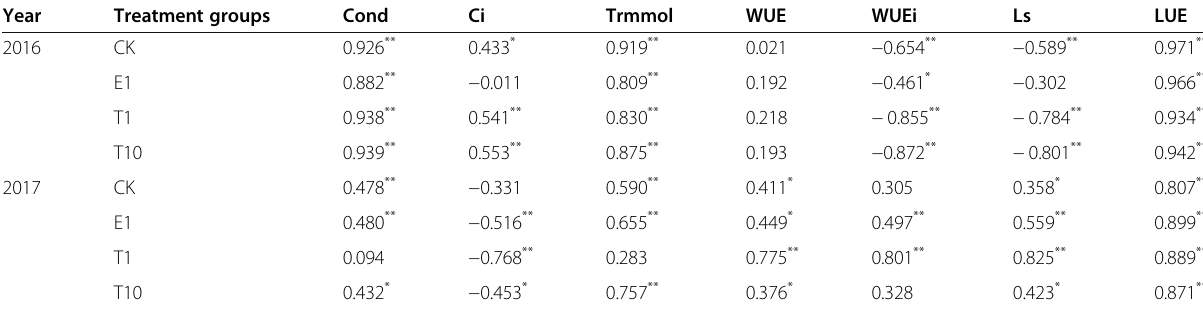
Table 2 Correlation coefficients of net photosynthetic rate (Pn) and other gas exchange parameters in various treatment groups: 1 and 10 days before the first irrigation (respectively T1, T10) and 1 day before the second irrigation (E1) after seedling emergence during 2016 – 2017 ( n = 30)